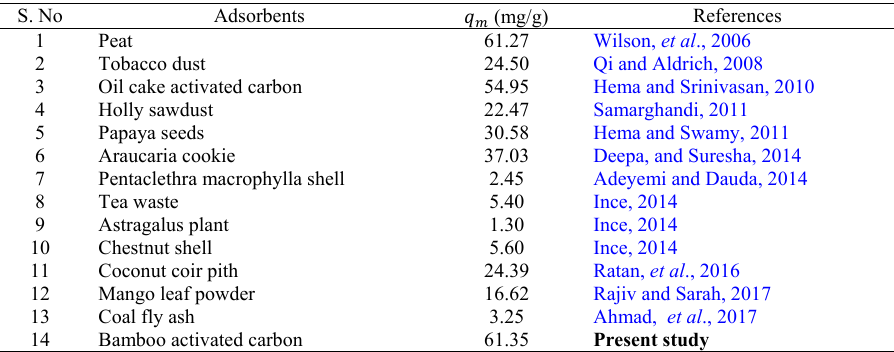
Table 5: Maximum adsorption capacity by different adsorbents